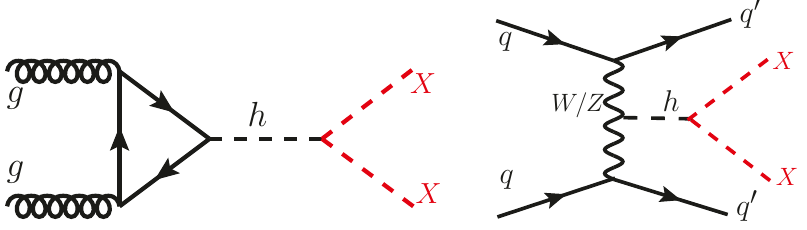
Figure 2 . The processes of producing the long-lived particle X from SM Higgs decay considered in this study. Left panel: gluon-gluon fusion Higgs production. Right panel: vector boson fusion Higgs